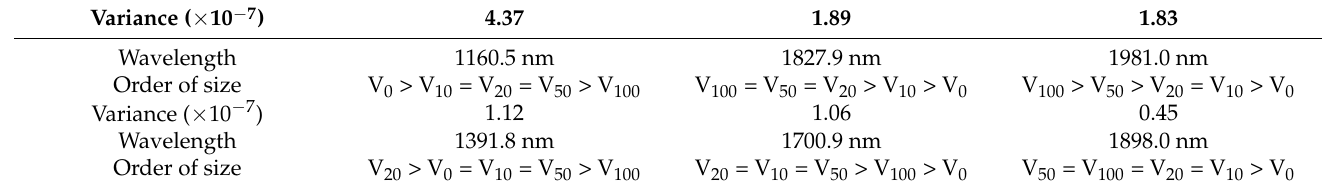
Table 1. Variance and order of average spectral intensity at different wavelengths.